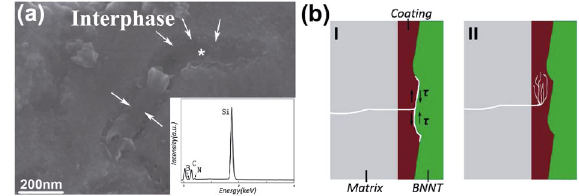
Fig. 6 (a) High-magnification SEM image of debonding morphology at the BNNTs/matrix interface. White arrows indicate the adherence of the interphase. The inset shows EDS result taken from the debonding zone as marked by white asterisk in the image. (b) Schematic diagrams depicting crack deflection at the BNNTs/matrix